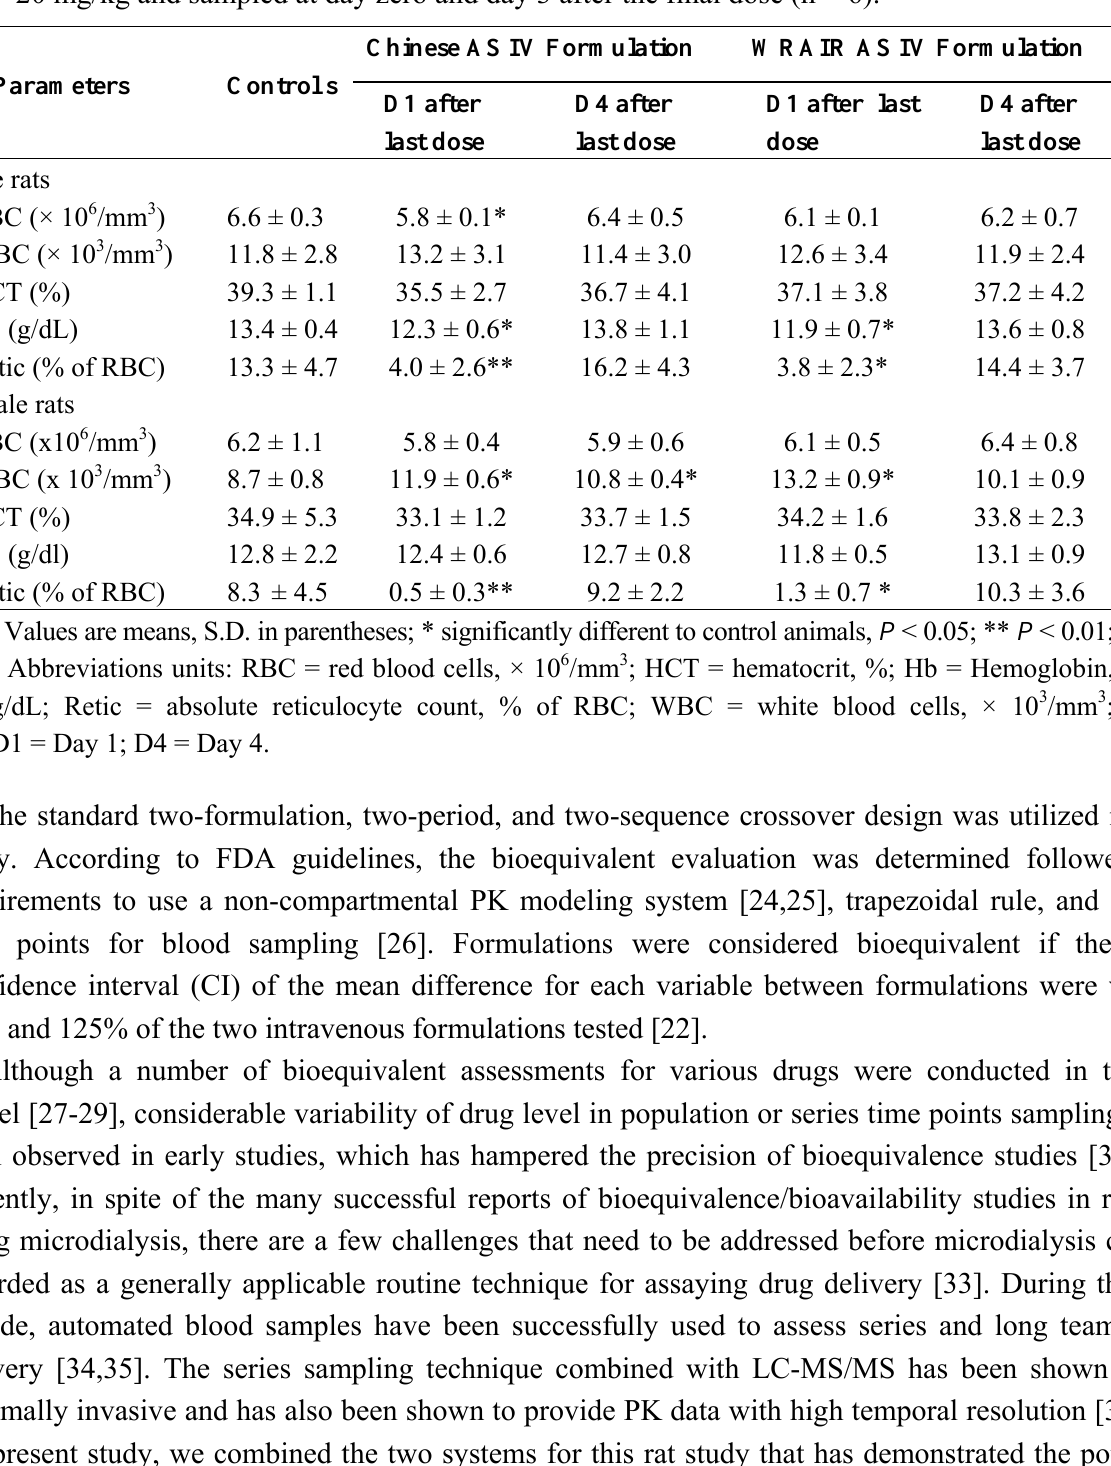
Table 4. Hematological results from male and female rats dosed with multiple injectable artesunate (AS) in Chinese and WRAIR formulations daily for 3 days at dosage of 20 mg/kg and sampled at day zero and day 3 after the final dose (n =